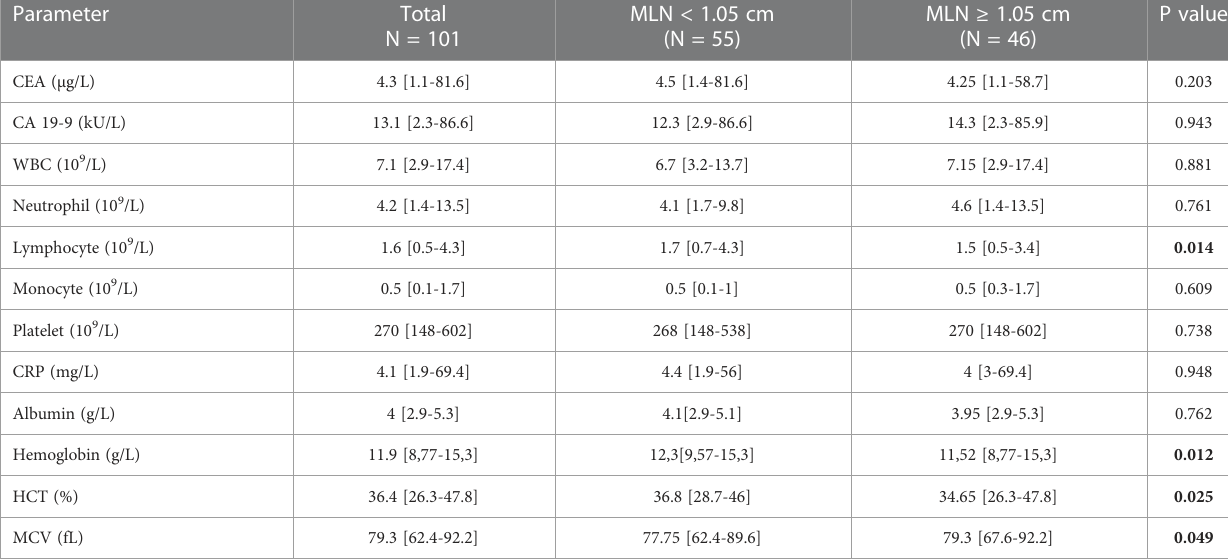
TABLE 6 Preoperative laboratory fi